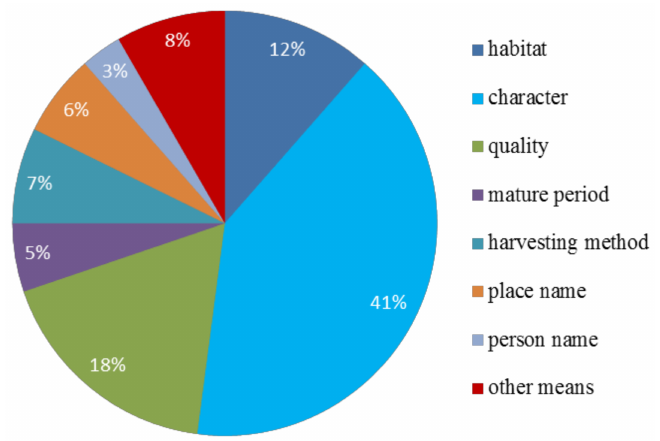
Figure 3. The seven naming methods for Kam fragrant glutinous rice.